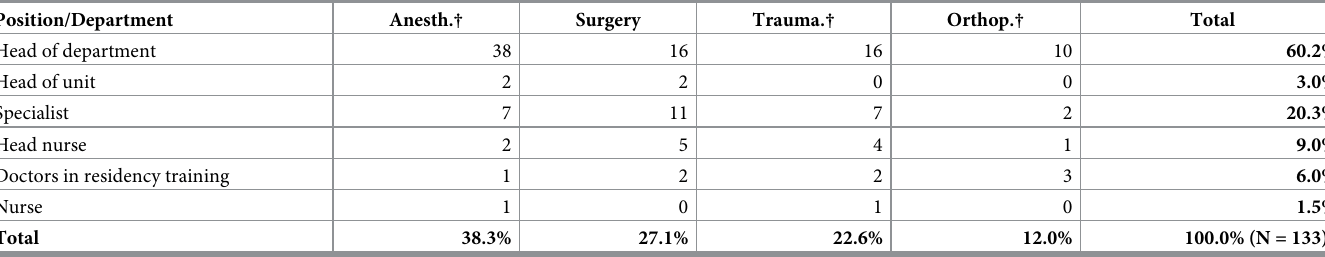
Table 3. Distribution of the respondent health professionals by position and place of